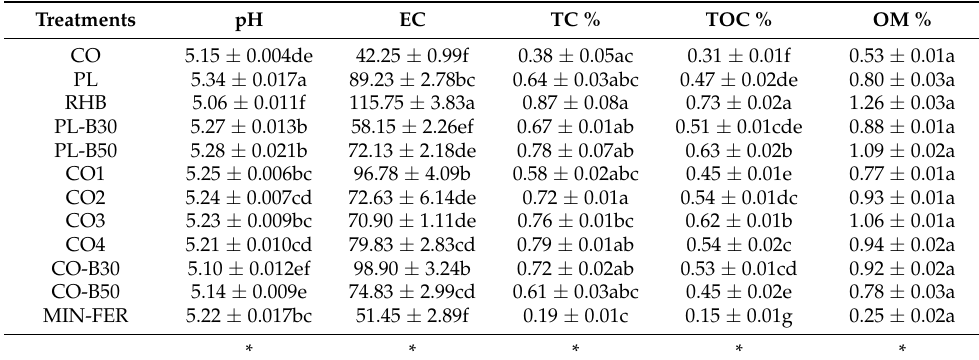
Table 7. Soil properties at